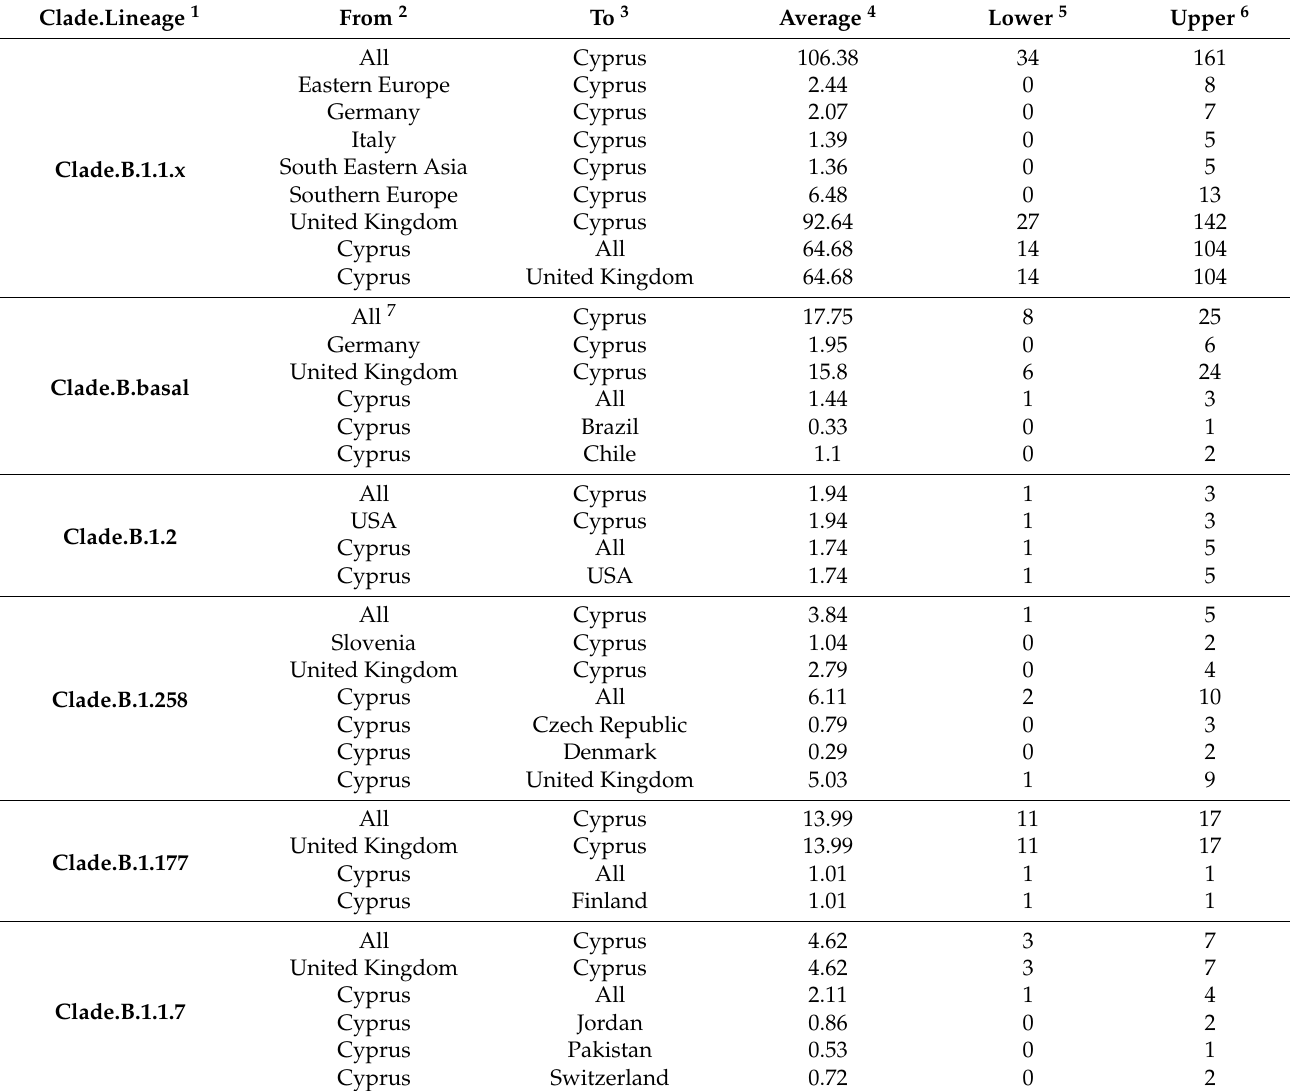
Table 2. The estimated number of migration events towards and from Cyprus. Lower and upper refer to the bounds of the 95% HPD interval. Clade.Lineage 1